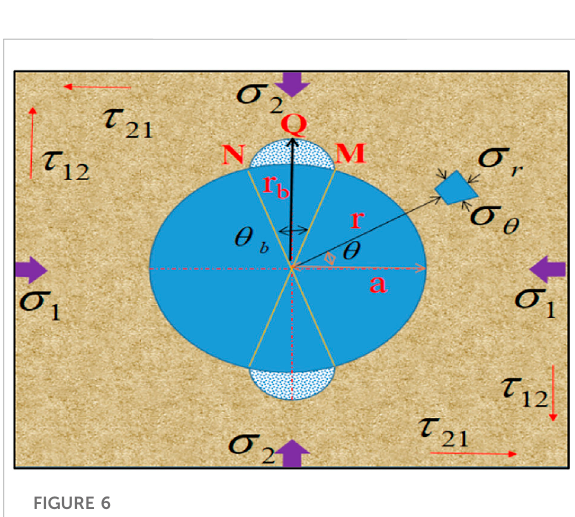
FIGURE 6 Schematicdiagramofcircumferentialstressstateofborehole cross